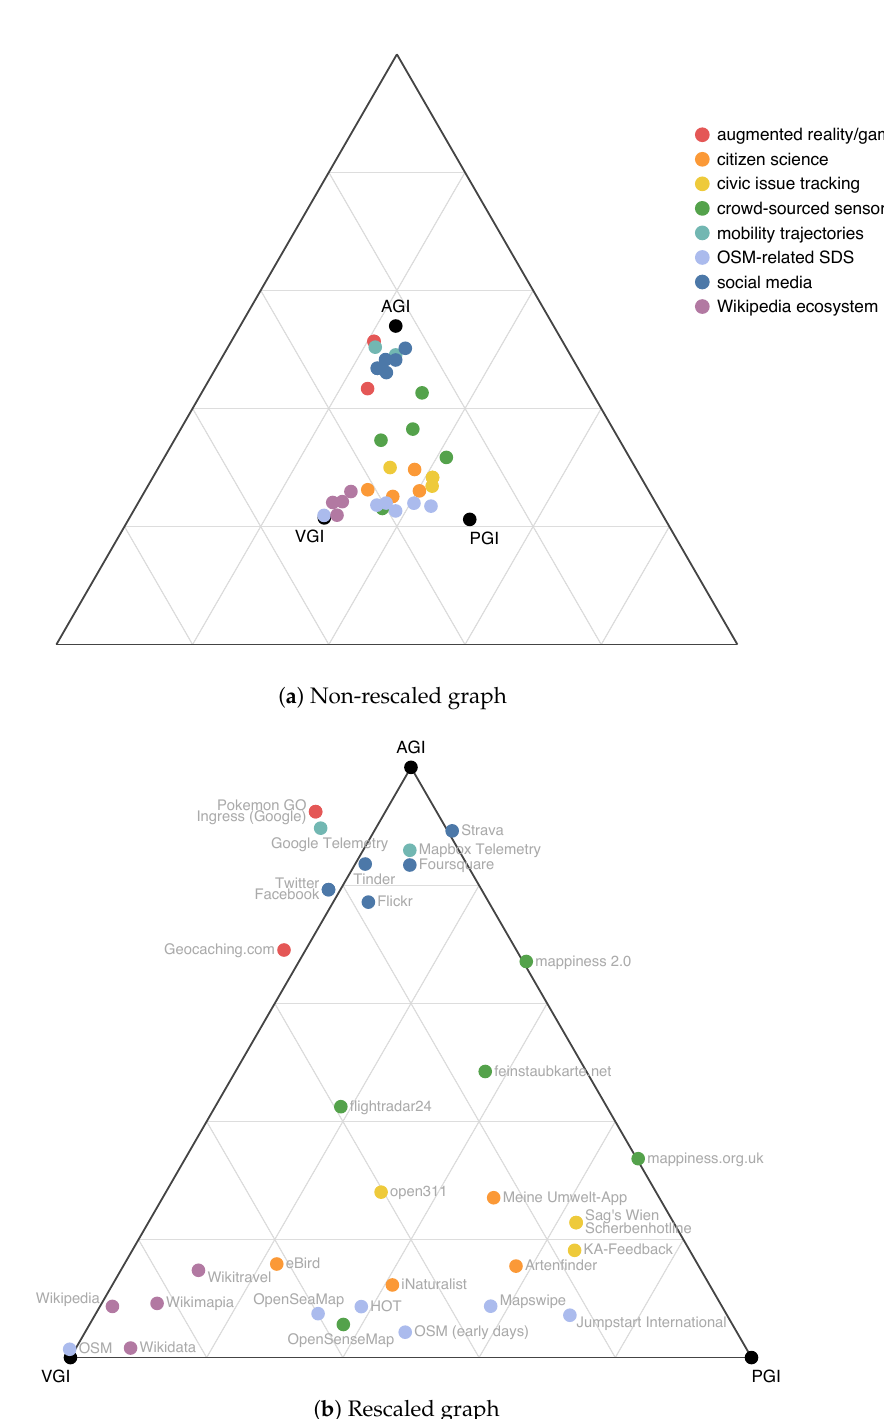
Figure 2. Trilinear graph of Geographical Shared Data Sources (GSDSs), the ‘Triangle of Shared Data Sources’. The graph ( b ) depicts a rescaled version of ( a ), in which the prototypes are represented at the corners of the